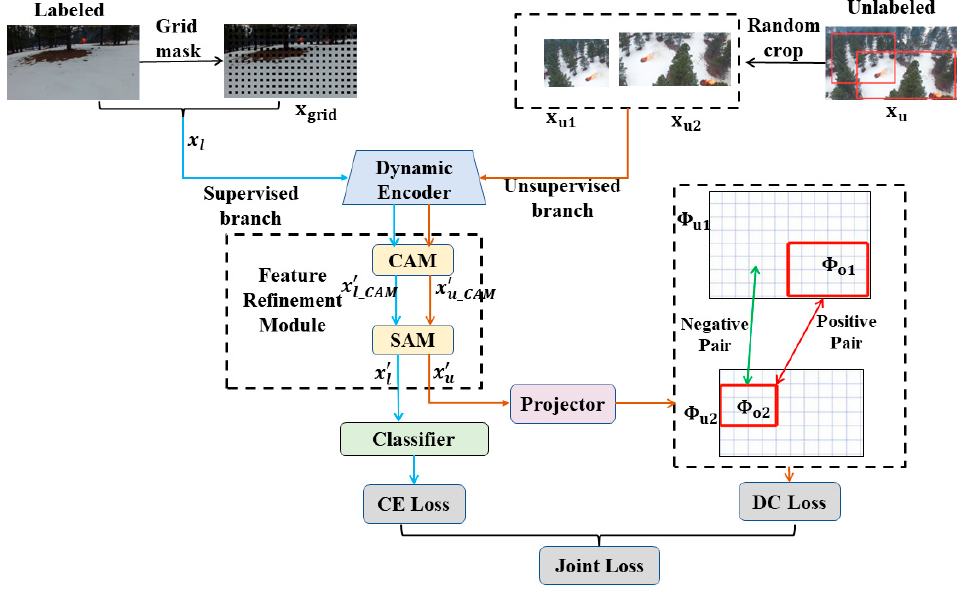
Figure 1. Overall structure of the proposed SemiFSNet.